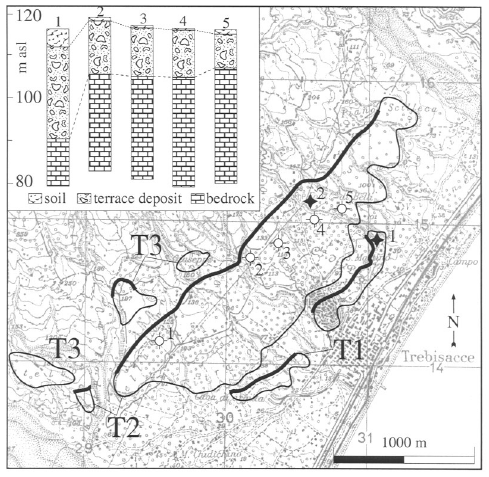
Fig. 7. Map of the Trebisacce area. Diamonds indi- cate the sites of the samples; dots are the location of five boreholes drilled onto T#2 for the construction of a highway. The stratigraphy of the boreholes is re- ported in the inset; at this location the thickness of the terraced deposits varies between 8 and 20 m. Eocene sandstones and calcarenites are the bedrock. The con- tour interval of the background map is 25